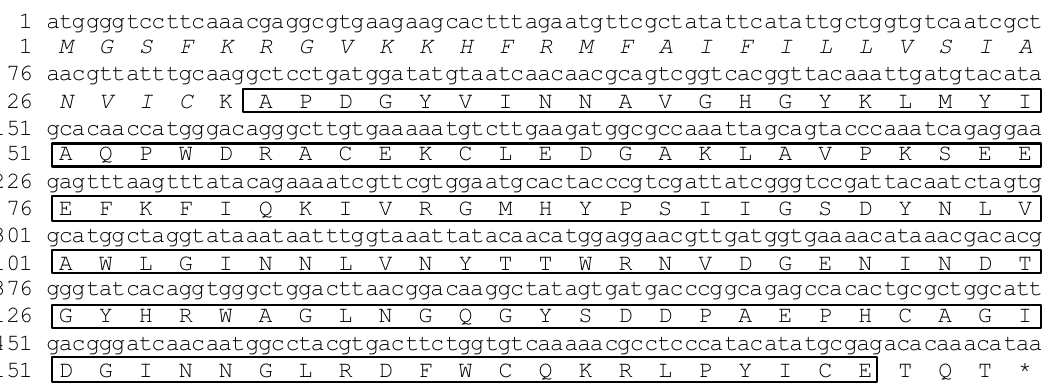
Figure 2. Nucleotide and amino acid sequences of Aplectin-5. Italic amino acids indicate the signal peptide and the boxed amino acids indicate the carbohydrate recognition domain.